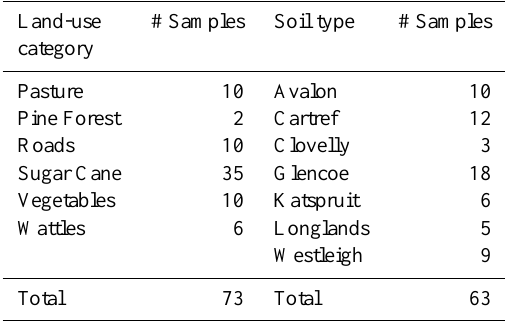
Table 2. Summary of samples collected in May 2008. Samples from roads were not included in the statistical analysis (see